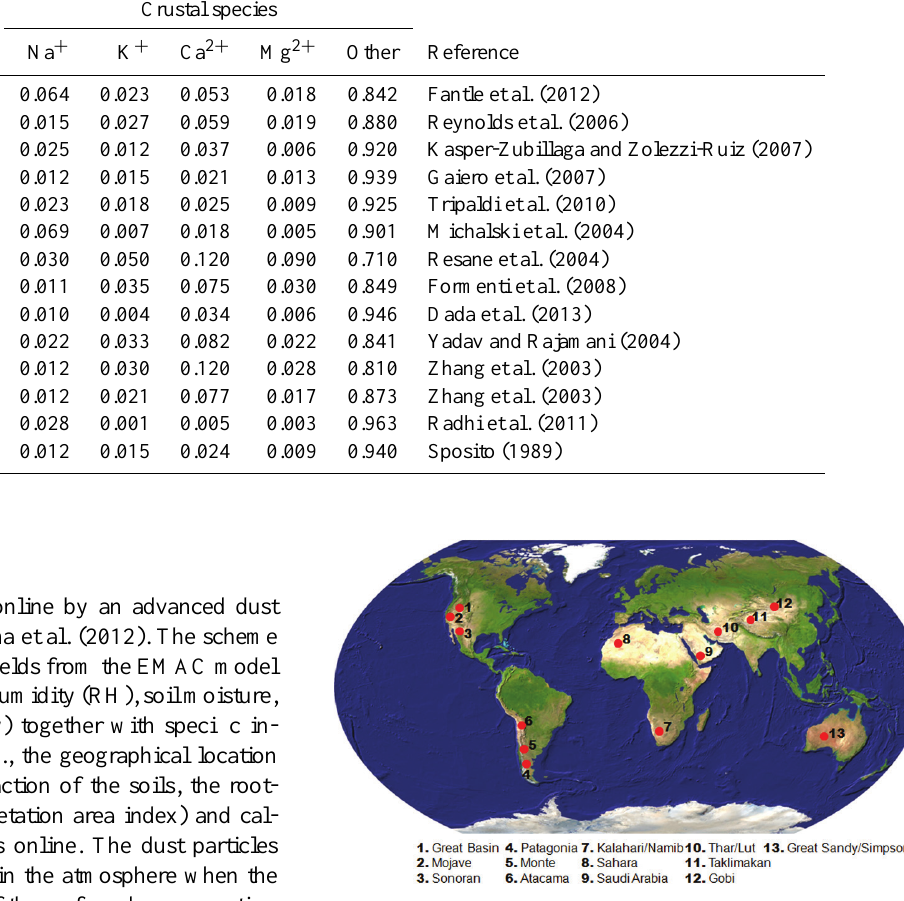
Figure 1. Location of the main desserts of the world in which a discrete chemical composition of the emitted mineral dust is